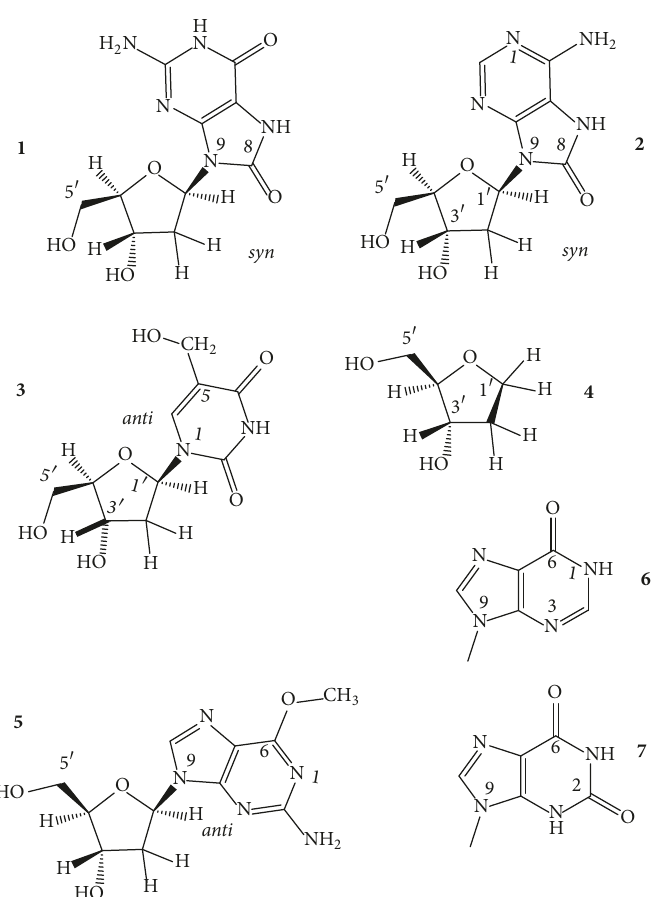
Figure 15: Structures of the syn 8-oxo-2 󸀠 -deoxyguanosine ( 1 ); syn 8-oxo-2 󸀠 -deoxyadenosine ( 2 ); anti 5-hydroxymethyl-2 󸀠 -deoxyuridine ( 3 ); the tetrahydrofuranyl abasic site ( 4 ); anti O6-methyl-2 󸀠 -deoxyguanosine ( 5 ); hypoxanthine ( 6 ); and xanthine ( 7